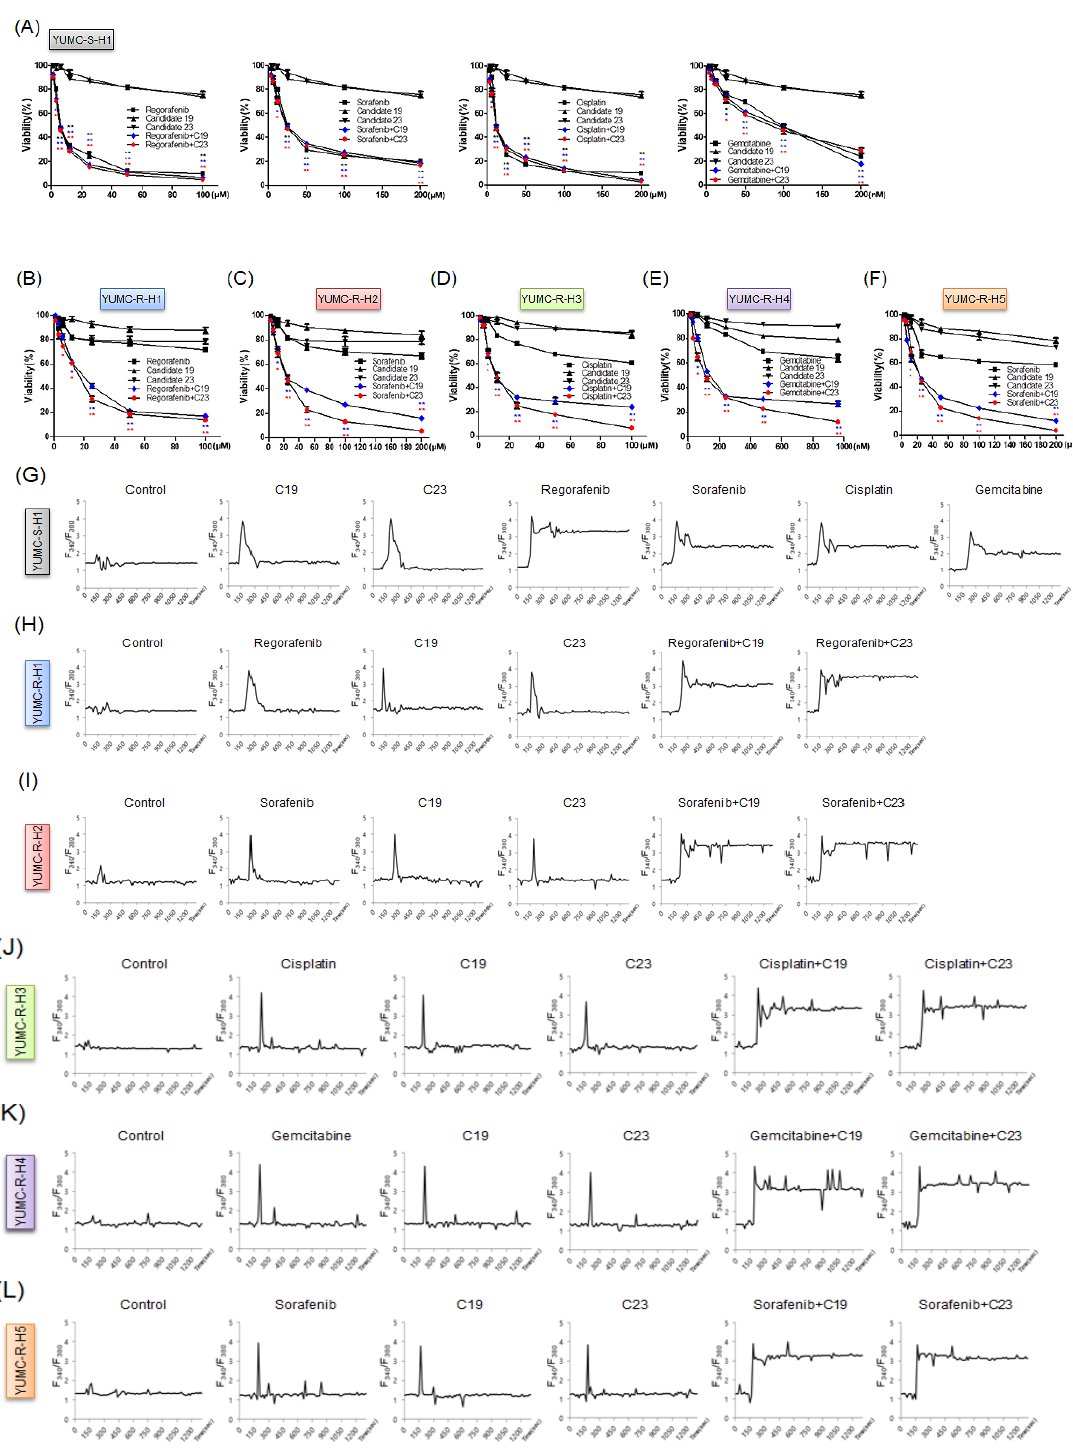
Figure 4. Synergistic anti-cancer effects of candidates 19 and 23 in patient-derived anti-cancer drug- resistant HCC cells. The viability of ( A ) YUMC-S-H1 and ( B – F ) YUMC-R-H1, -H2, -H3, -H4, and -H5 treated with regorafenib, sorafenib, cisplatin, or gemcitabine combined with candidates 19 or 23 or with each agent alone. Points indicate the mean percentage of the values of solvent-treated control. All experiments were repeated at least thrice. Data represent the mean ± standard deviation. * p < 0.05 and ** p < 0.01 versus control. ( G – L ) Cytosolic free calcium was measured in patient-derived HCC cells treated with anti-cancer